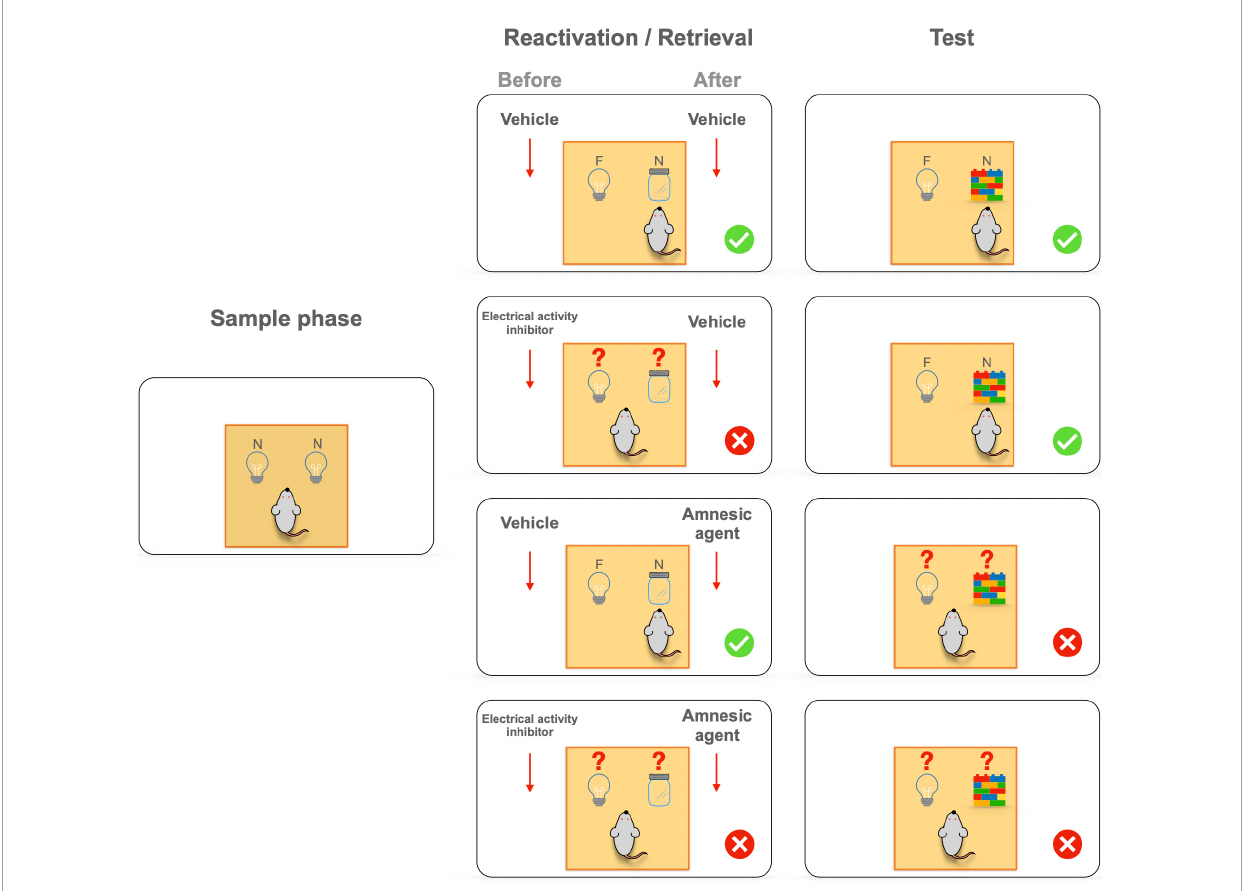
FIGURE2 Memory expression is not essential for memory editing and updating. The administration of an expression blocker (a GABA receptor agonist or an AMPA receptor antagonist) before the reactivation/retrieval session impairs recognition memory, since rats could not differentiate between the novel (N) and familiar objects (F). However, rats showed preference for a novel object in the test session, revealing that the original object-related memory remained intact despite inhibition of memory expression. Moreover, the administration of an amnesic agent (a protein synthesis inhibitor) after the reactivation/retrieval session promotes object-related retrograde amnesia, since rats could not differentiate between the familiar and novel objects during the test session. The combined administration of an expression blocker (before reactivation/retrieval session) and an amnesic agent (after reactivation/retrieval session) blunts memory expression during the reactivation/retrieval session and induces object-related amnesia (Based on Balderas et al.,